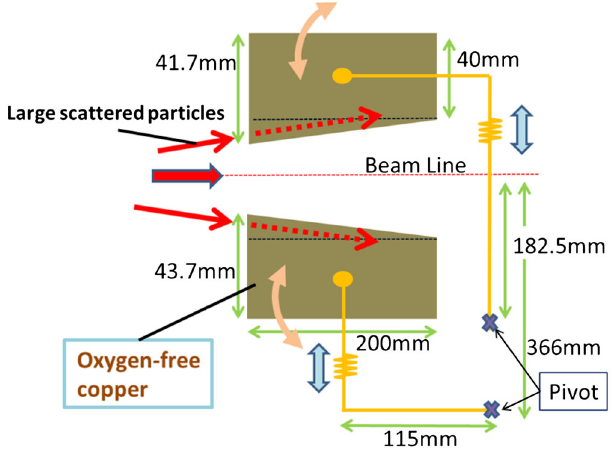
FIG. 6. Schematic drawing of the